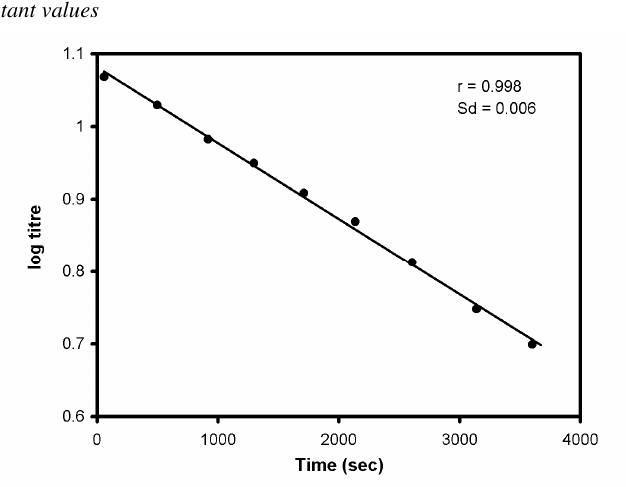
Figure 1 . Plot of time versus log